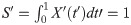
Ecological fluctuations show universal avalanche scaling laws.A, Time series of species abundance (protozoa, rotifers, calanoids) in an isolated plankton community [28] (top), rock coverage by intertidal mollusks [3] (middle), and forest carbon fluxes [29] (bottom) show sustained aperiodic fluctuations varying in size and duration. Magnitudes (X) are normalized by mean value for each dataset. B, The probability distributions of avalanche durations follow a universal power law across communities. Avalanche duration (T) and corresponding size (S) are defined in inset. Blue, cyan, purple: herbivore, detritivore, and producer trophic levels in the plankton community; green: forest carbon flux; brown, yellow: barnacle and algae in the intertidal community. Due to the small number of events in the intertidal community, this dataset is supplemented with the model provided in the original paper (triangle) [3]. The empirical data are in quantitative agreement with the linear response model at marginal stability (Eq 1, λ = 10−3, grey line). C, The distributions of avalanche sizes follow a universal power law. Sizes are shifted horizontally to account for varied units between datasets. D, Scaling of average avalanche size vs. duration follows a power-law conserved across communities and the linear response model (grey line). Translucent symbols: individual avalanche events; solid symbols: bin-averaged values. In B-D, individual groups are collapsed through leading coefficients. E, Average avalanche shape converges across datasets and the linear response model. Each avalanche event is isolated and normalized to unit duration (t′ = t/T) and unit size (X′ = X/ST−1, resulting in S′=∫01X′(t′)dt′=1). Trajectories from each dataset are then averaged to produce the avalanche shape separately. Blue, yellow, green: plankton, intertidal, and forest data. Dashed line: modeled intertidal community. Grey line: linear response model at marginal stability (λ = 10−3).